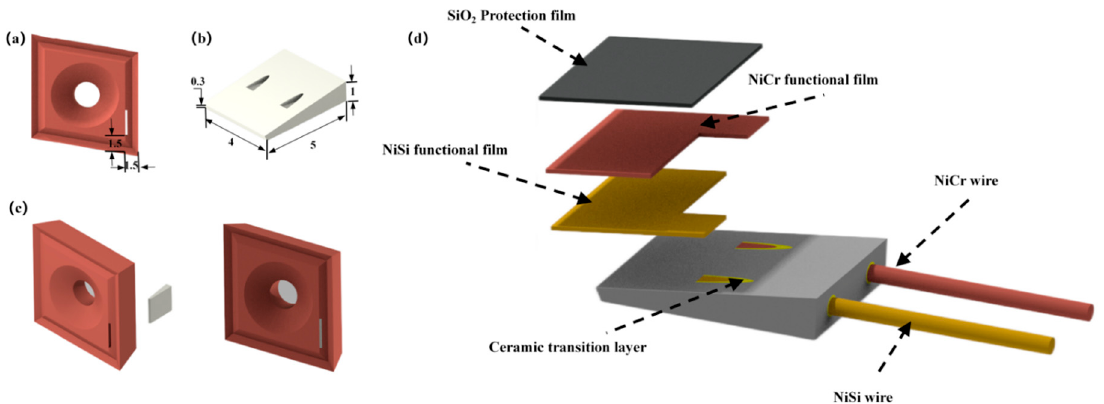
Figure 3. Sensor assembly diagram: ( a ) Position of wedge. ( b ) Substrate of sensor. ( c ) Sensor and blade assembly. ( d ) Structure diagram of new film thermocouple temperature sensor.